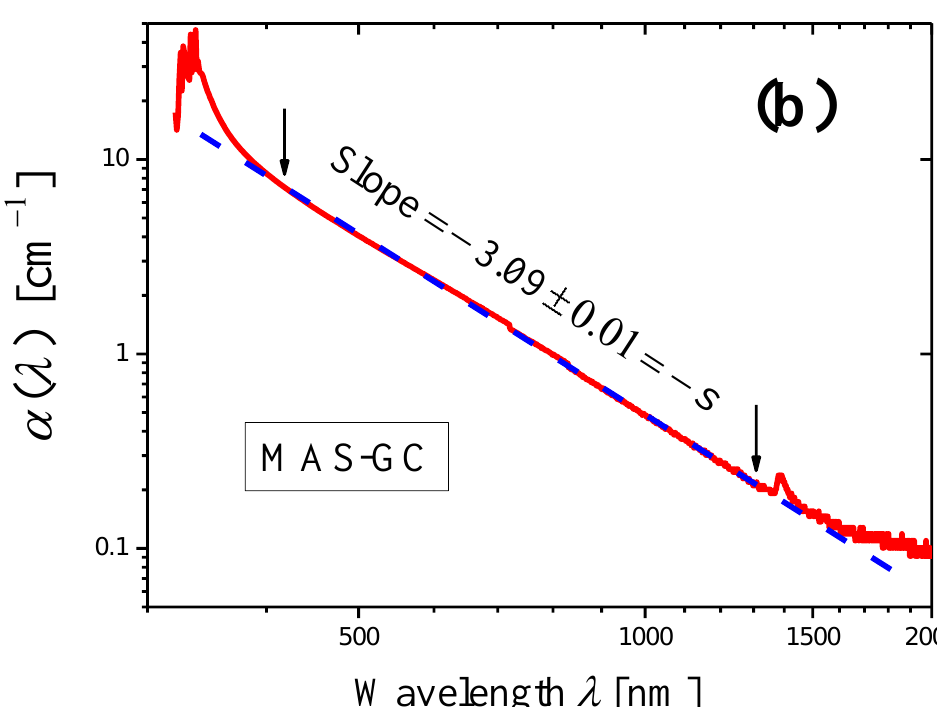
Figure 4. ( a ): Log–log plots of the measured optical densities for two samples of the MAS-GC with thicknesses indicated in the figure. ( b ): A log–log plot of wavelength dependence of the extinction coefficient α ( λ ) determined by Equation (5) on the basis of the data presented in Figure 4a (the first method).